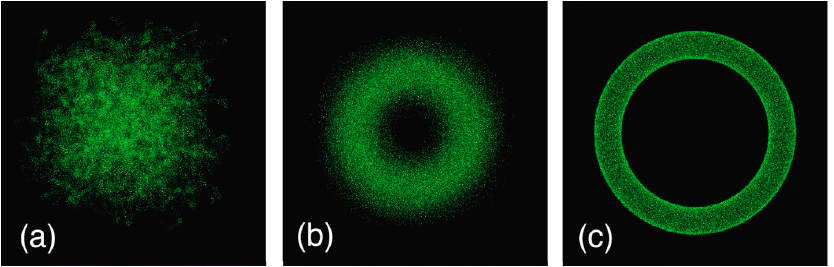
Figure 3. Visualization of the interactive Mandala for ( a ) low ( b ) intermediate, and ( c ) high levels of the meditation (M) parameter (reproduced from [34], page 2—Figure 2, with permission of the